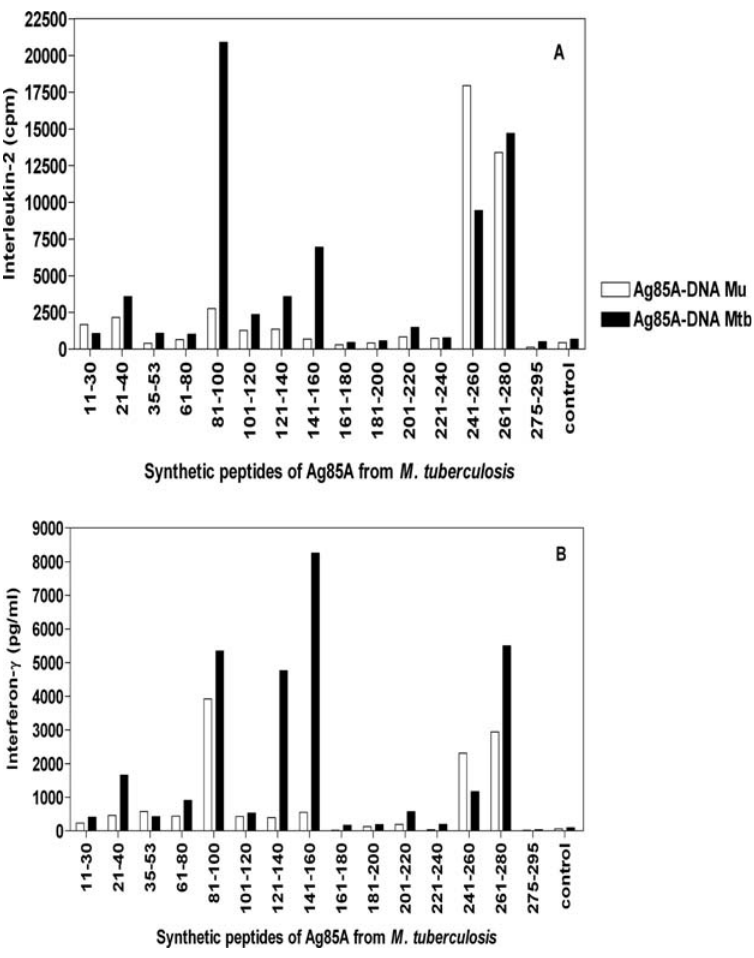
Figure 4. Spleen cell IL-2 (A) and IFN- c (B) responses to whole Ag85A- M.tuberculosis and its synthetic peptides in a pool of six B6 mice vaccinated, at three weeks interval with Ag85A-DNA M.ulcerans (white bars) or Ag85A-DNA M.tuberculosis (black bars).